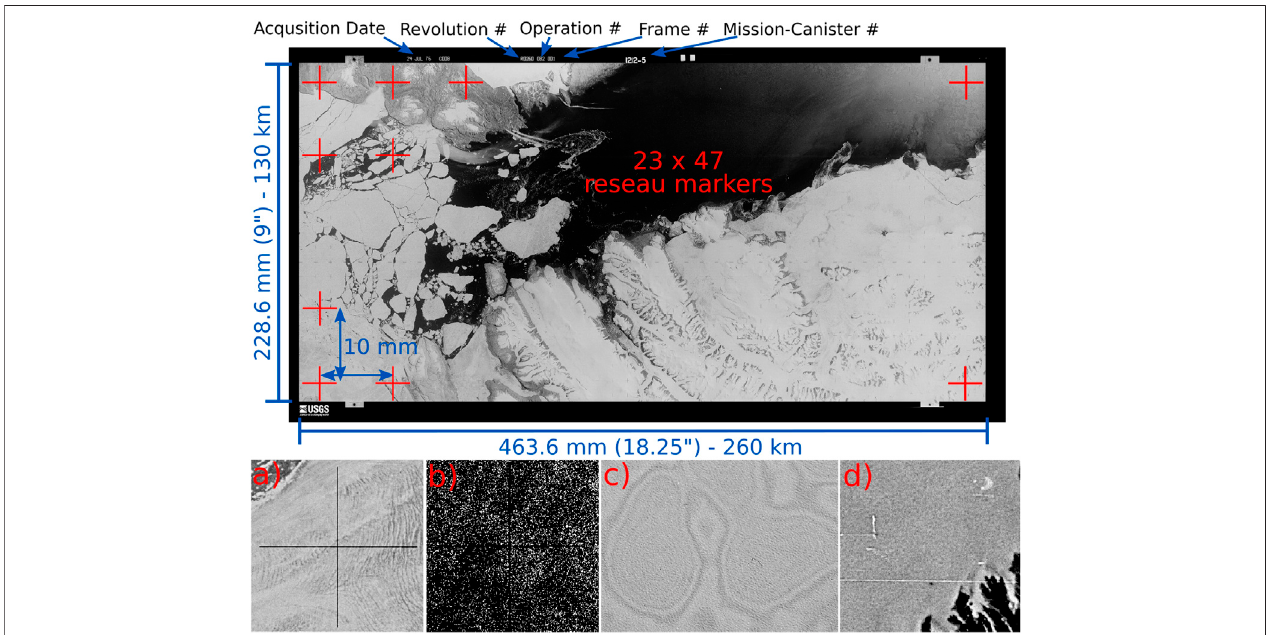
FIGURE2| SampleKH-9MCimageovertheCanadianArctic(IDDZB1212-500082L001001),afterstitching.Theimagedimensionsandmetadatainformationare highlighted in blue. Each image has 23 × 47 reseau markers (dark crosses). Detail of (A) reseau marker with good contrast, (B) reseau marker over water with limited contrast (Digital number stretched from 0 – 5 to bring out detail, rather than 0 – 255 as in A ), (C) interference pattern known as Newton ’ s rings, caused by the re fl ection of light when the fi lm is not in contact with the scanner glass, and (D) scratches and defects on the fi